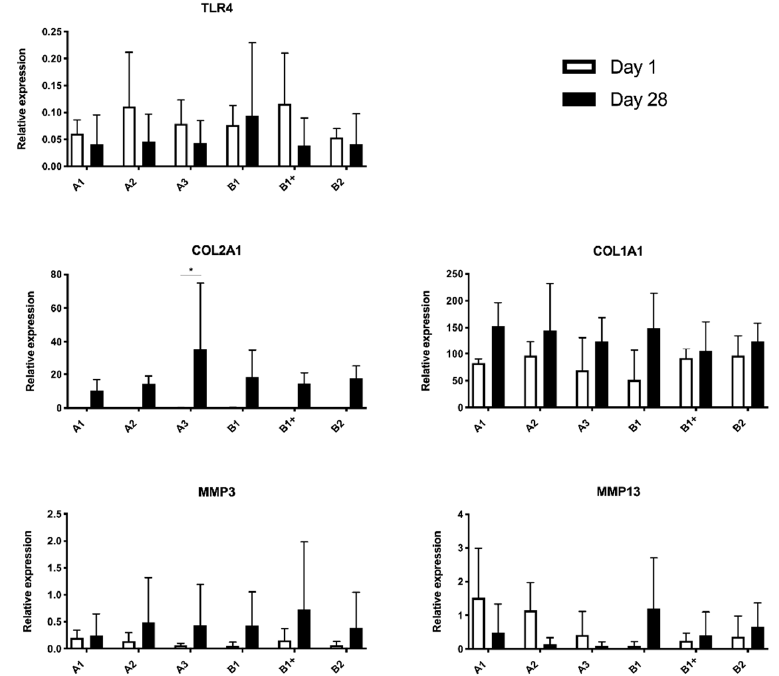
Figure A2. mRNA expression of MSCs from three donors cultured for 28 days in six different hydrogels from five GelMAs. Values represent mean ± SD of three donors on day 1 and day 28. *: p < 0.05.